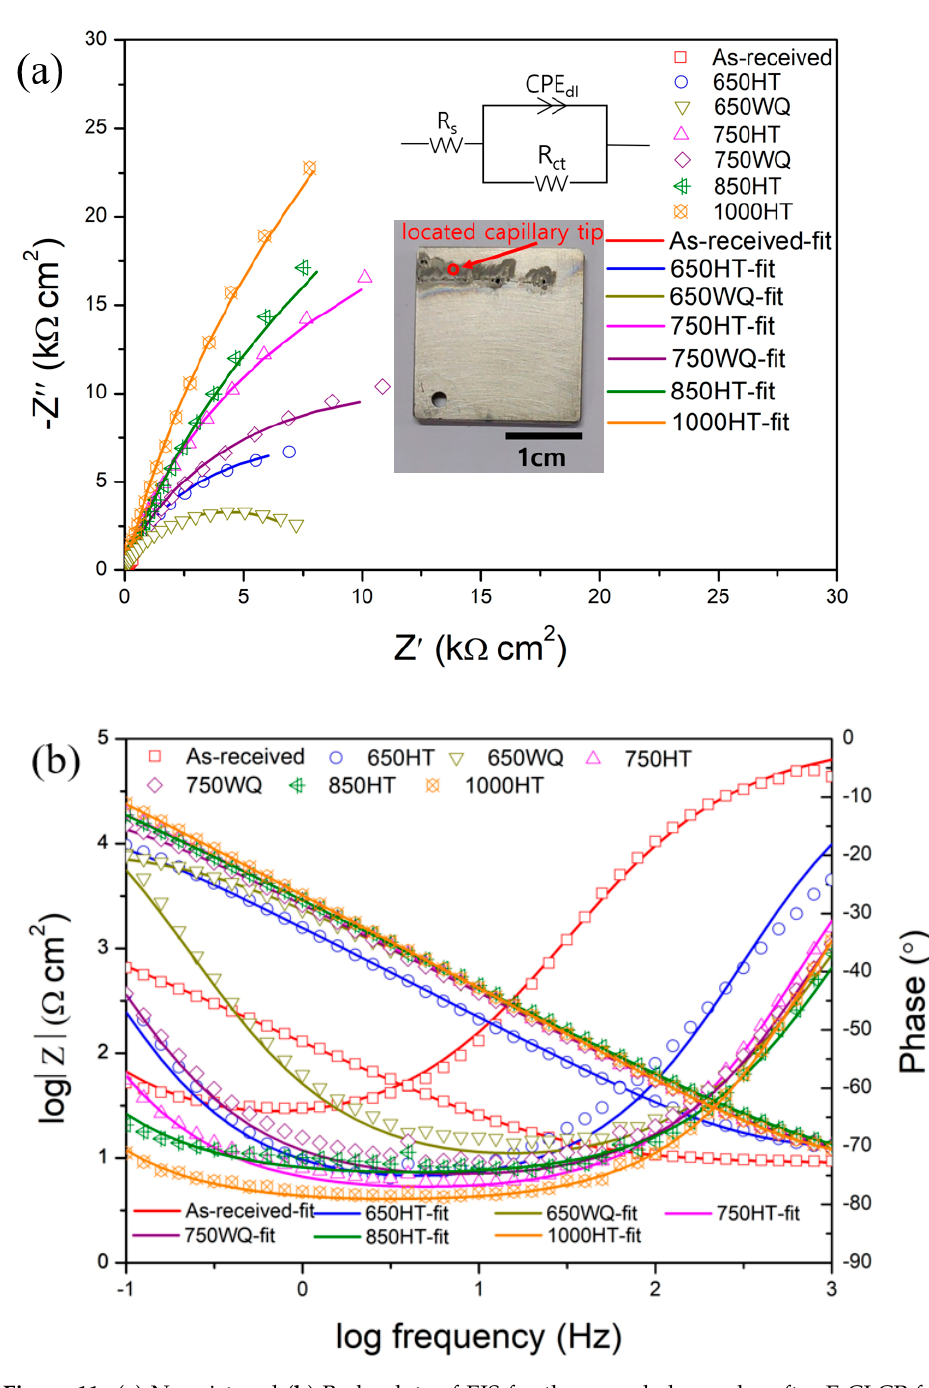
Figure 11. ( a ) Nyquist and ( b ) Bode plots of EIS for the corroded samples after E-CLCP for the as-received, HT, and WQ samples of AM Ti–6Al–4V alloys in Ringer solution. The insets show the equivalent circuit for fitting and the optical micrograph with the location of capillary tip in a microdroplet cell, respectively (HT: furnace cooling; WQ: water quenching).